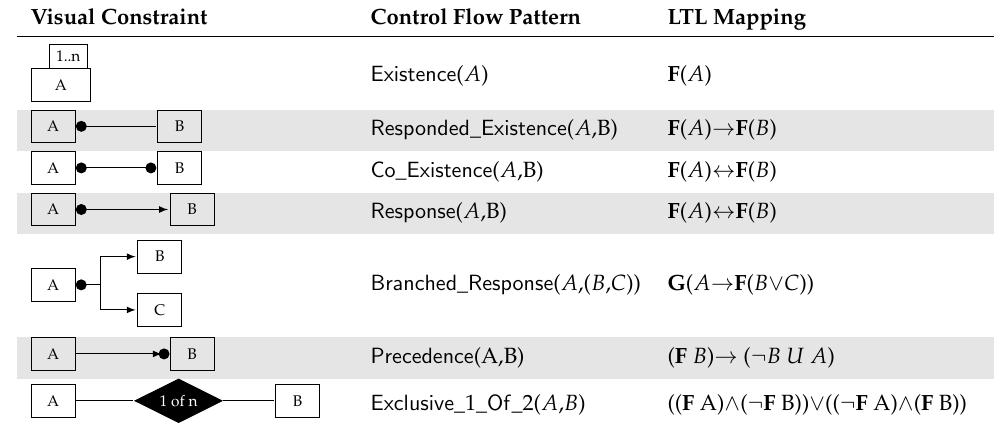
Table 8. Excerpt of Declare constraints (adopted from [57]). Visual Constraint Control Flow